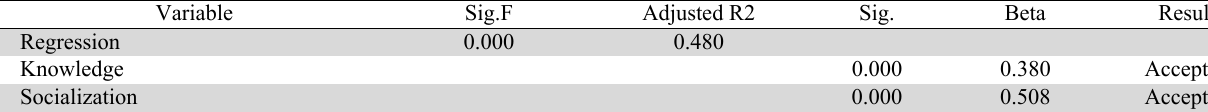
Results of Regression and Hypothesis Testing (1) Variable